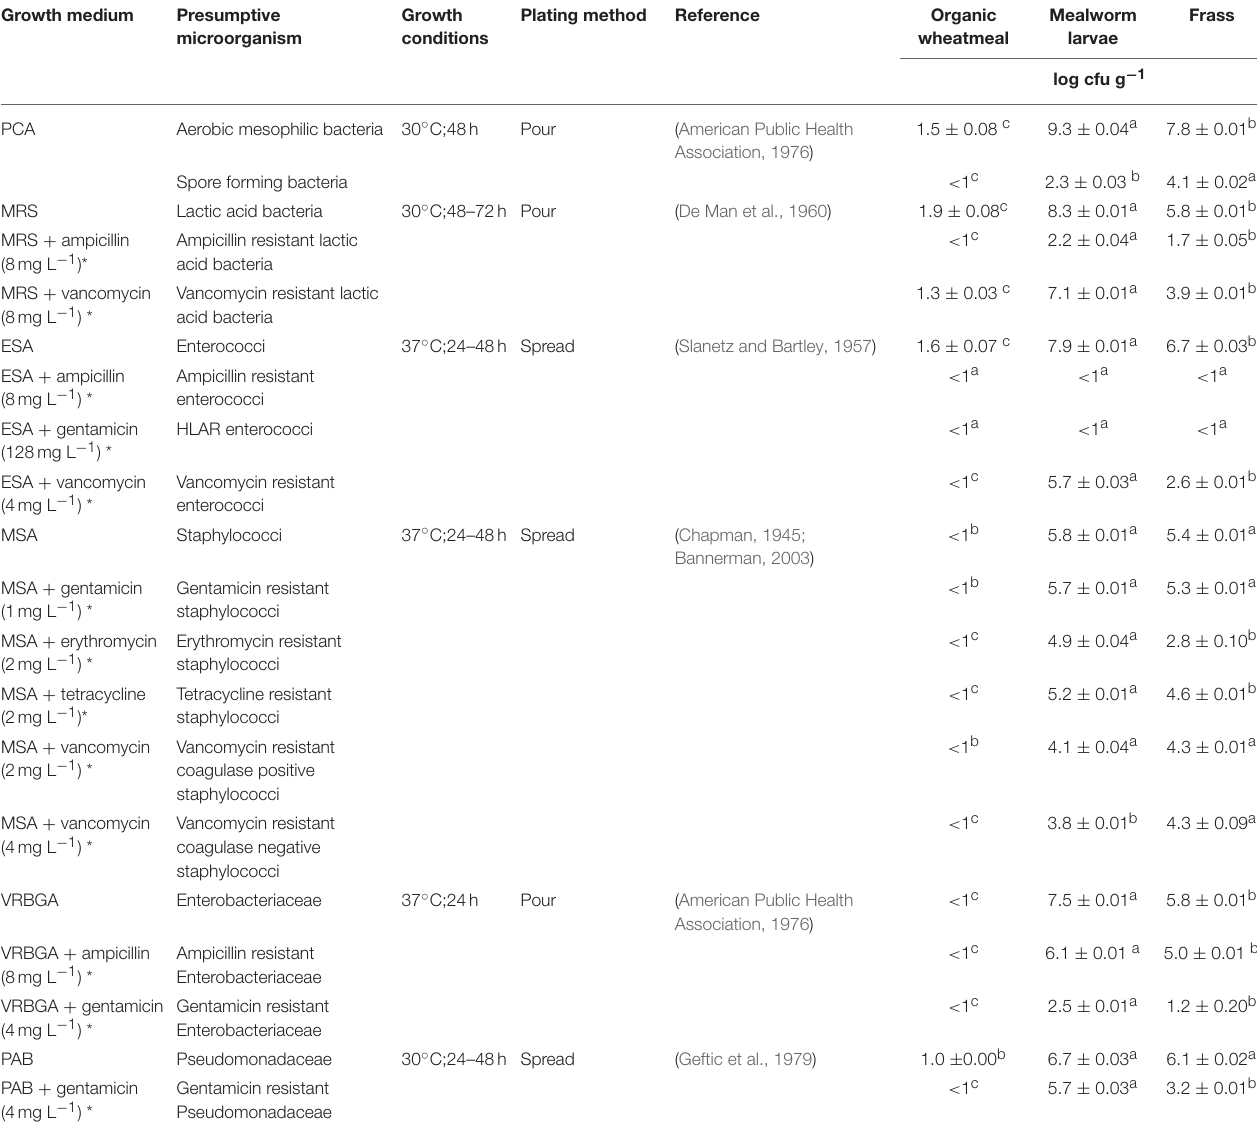
TABLE 1 | Culture media, incubation conditions and results of bacterial counts in wheatmeal used as feed, fresh mealworm larvae and frass of the three pooled rearing batches. Growth